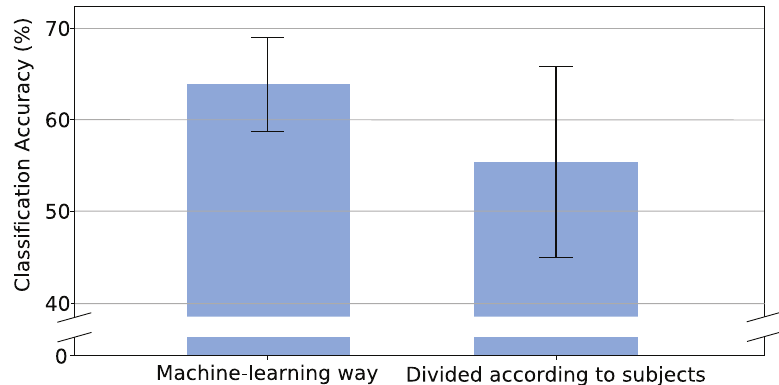
Figure 5. Work flow for the proposed approach.